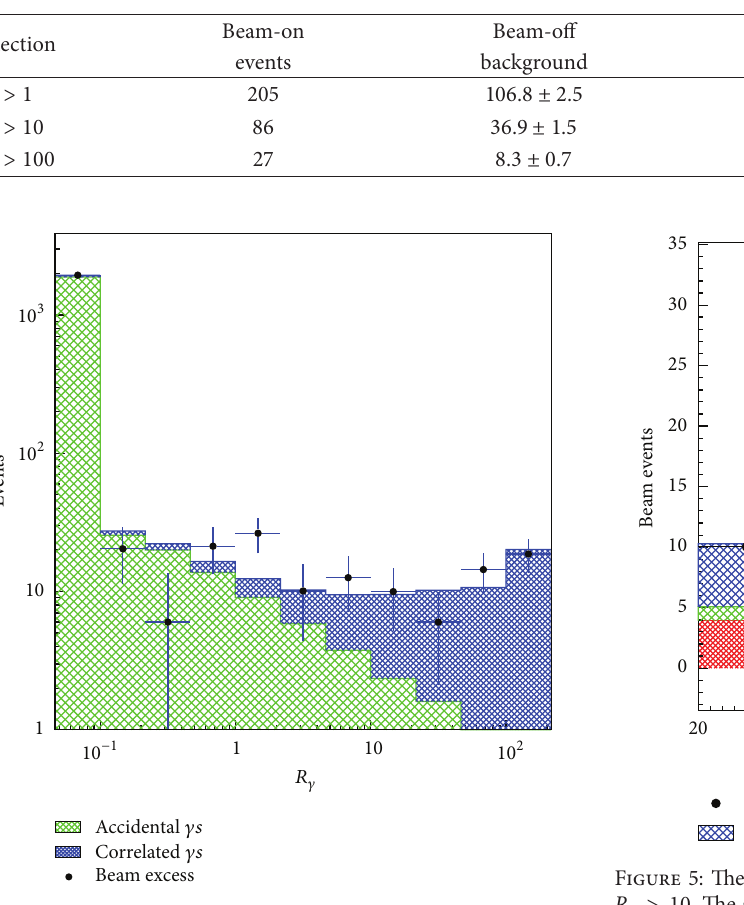
Figure 4: The LSND 𝑅 𝛾 distribution for events that satisfy the selection criteria for the primary ] 𝜇 → ] 𝑒 oscillation search.